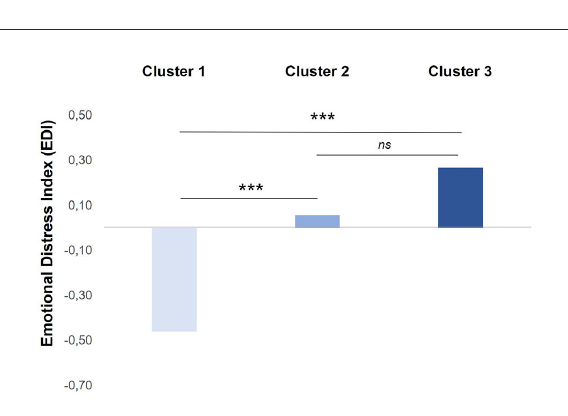
FIGURE2 Mean scores on EDI by clusters. ***, p < 0.001. EDI, emotional distress global